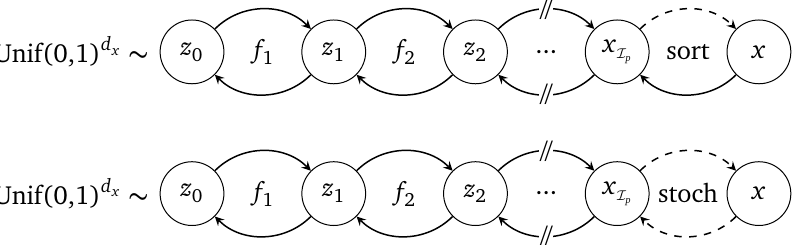
Figure 3: The normalizing flow architecture of figure 1 including a sort surjection or a stochastic permutation transform at the end. Solid arrows indicate deterministic transform directions, while dashed arrows are stochastic. The base distributions have been specified to a multivariate